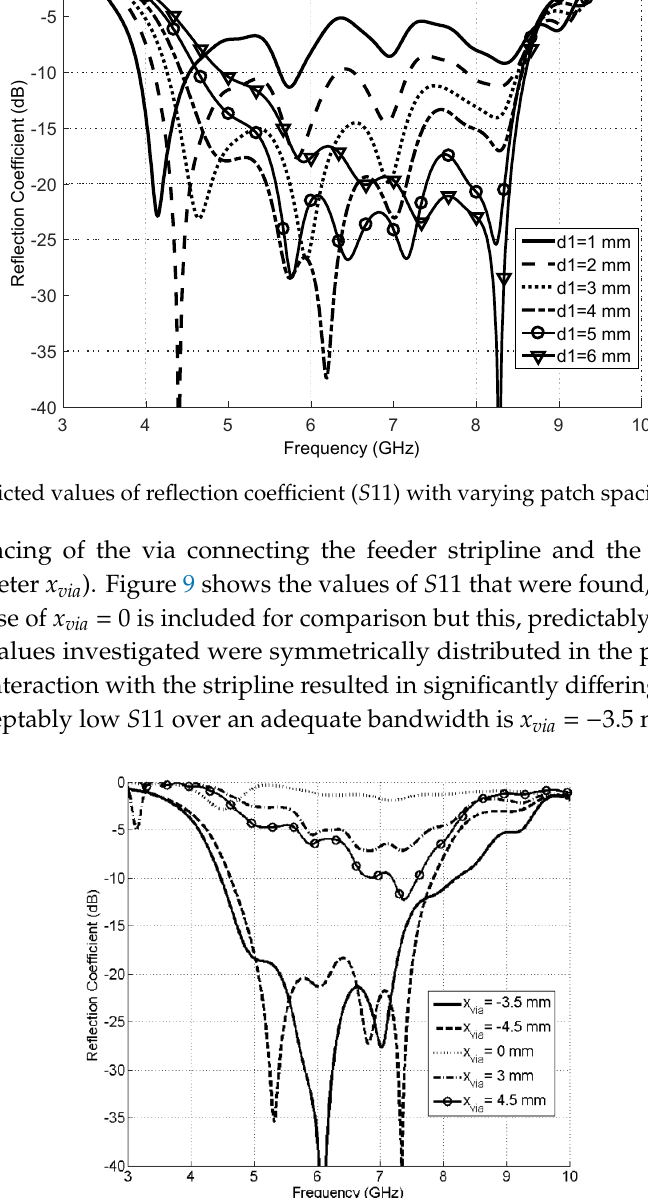
Figure 9. Reflection coefficient (S11) with different via ( x via ) locations.